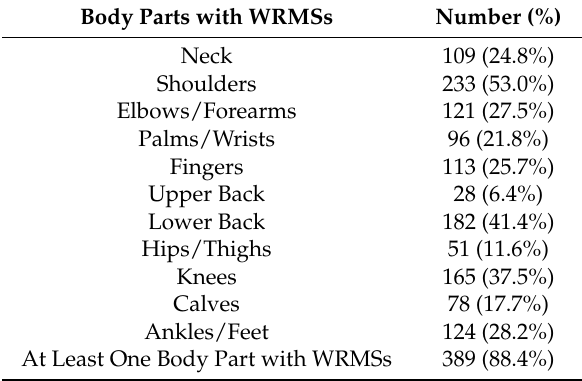
Table 2. Prevalence of work-related musculoskeletal symptoms (WRMSs) among NAs (N = 440) at the time of